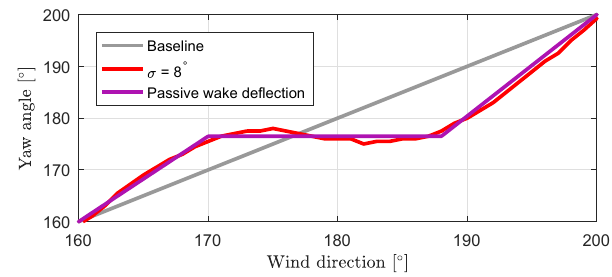
Figure 15. Exemplary illustration of the yaw angle set points of the reference turbine T32 according to the passive wake